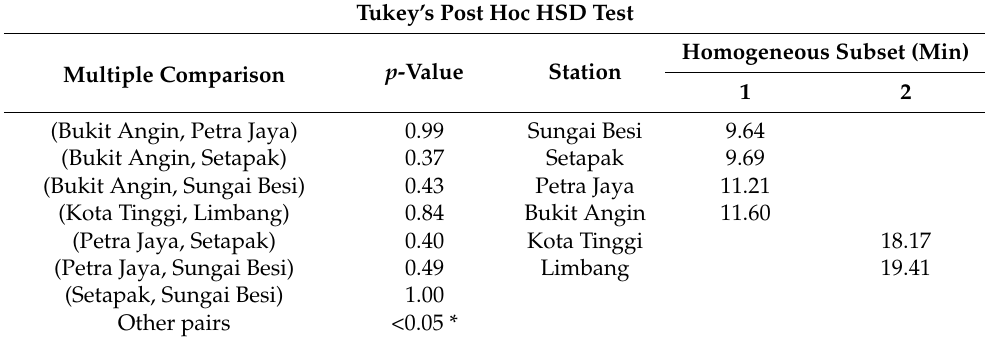
Table 6. Summary of Tukey’s post hoc HSD test for mean response times between category B fire stations.